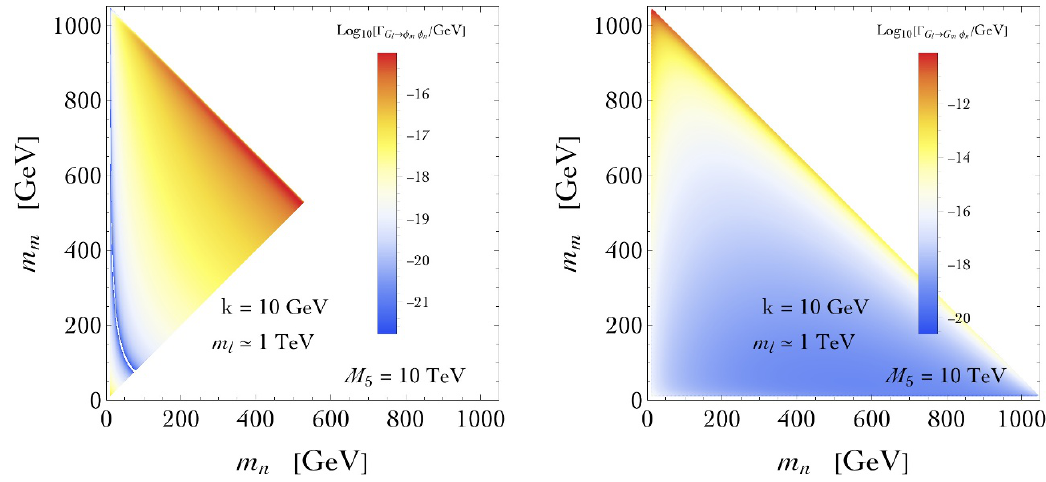
Figure 25 . Density plot of the decay widths (cid:0) G as a function of the (cid:12)nal state masses. The example shown is M 5 = 10 TeV, k = 10 GeV, for mode l = 1000. The corresponding mass of the decaying particle is m 1000 ’ 1